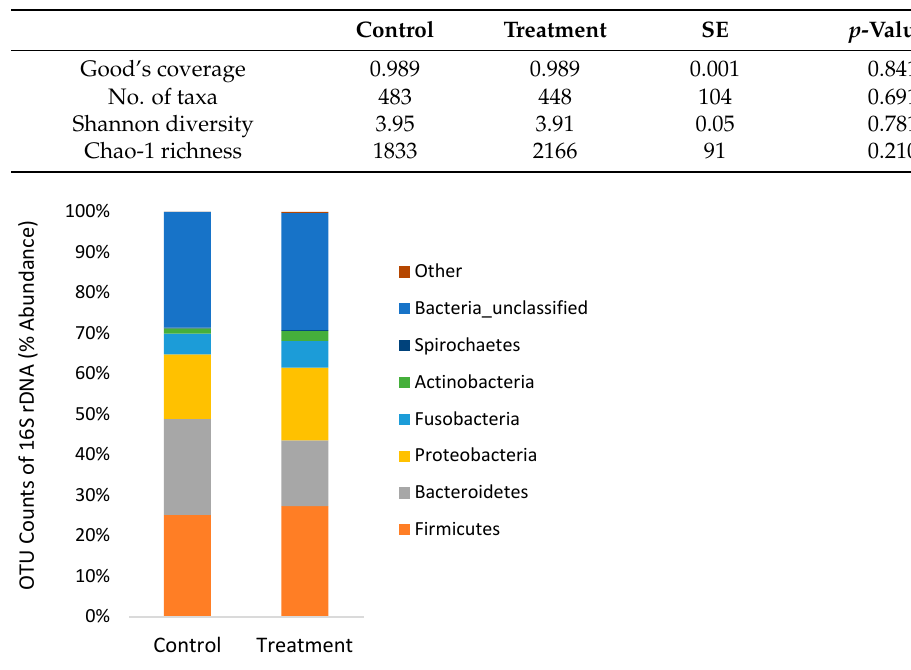
Figure 4. Relative abundance of OTUs on the phyla level clustered from 16S rDNA from the gut digesta ( n = 5) of rainbow trout.